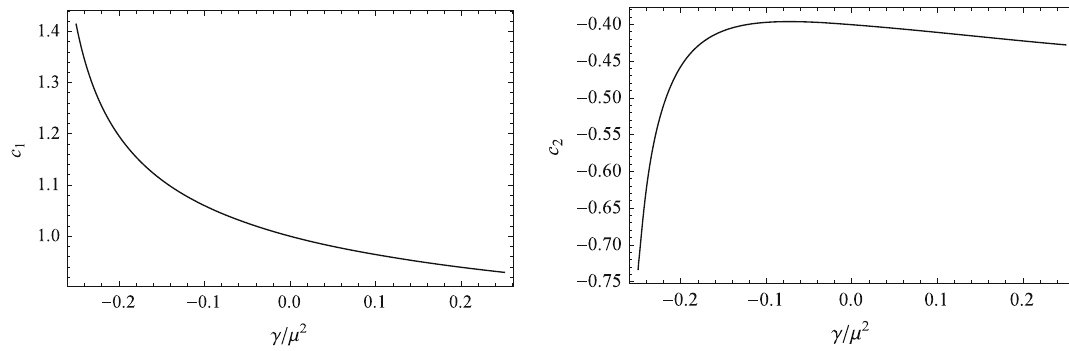
Fig. 1 The strong deflection limit coefficients c 1 (left) and c 2 (right) as functions of γ/μ